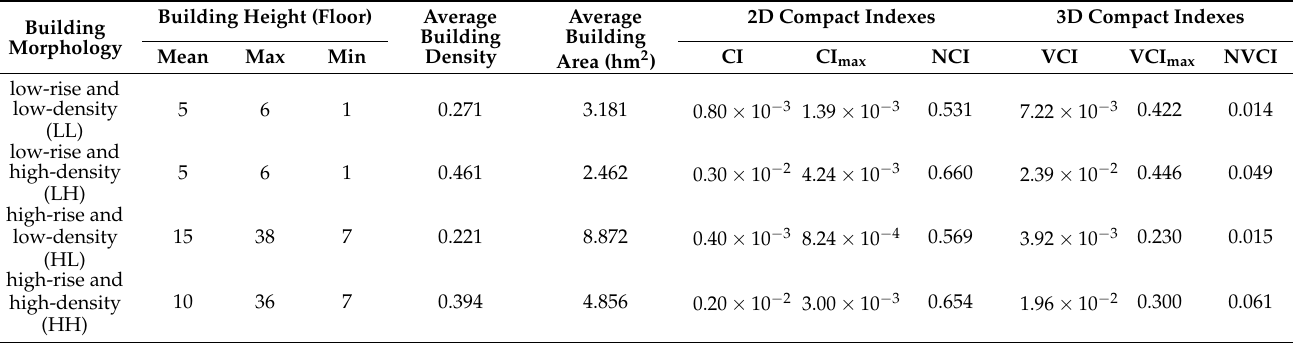
Table 3. Statistics of building characteristics for four typical urban morphology